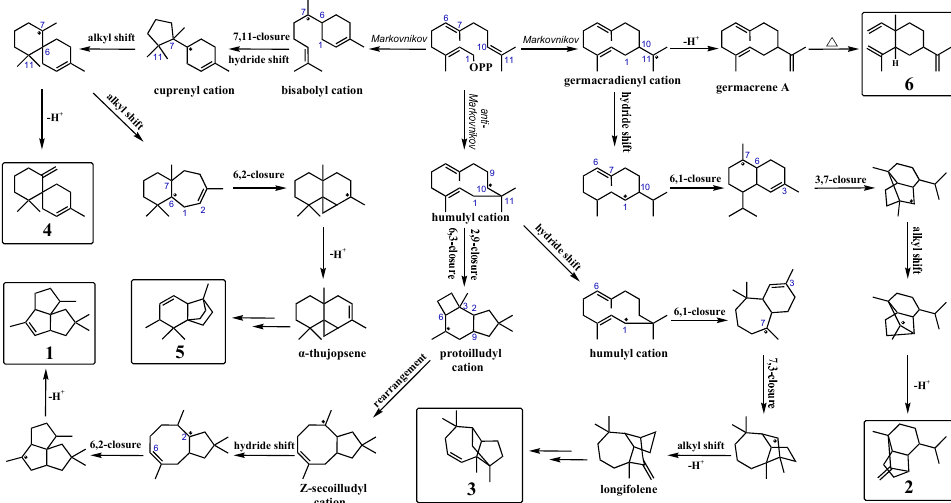
Figure 3. Predicted sesquiterpenes biosynthetic pathways of wild-type PentS and its variants. The products 1 and 3 were pentalenene and longifolene-V4, respectively, which were synthesized through anti-Markovnikov route initialed by 10, 11 double-bond attacked C1 and formed humulyl cation with positive charge on the less-substituted carbon (C10). The products 2 (sativene) and 6 ( β -elemene) were generated obeying Markovnikov’s rule initialed by 10, 11 double-bond attacked C1 and formed germacradienyl cation with positive charge on the more highly substituted carbon (C11). The products 4 ( β -chamigrene) and 5 (thujopsene-I3) were also generated following Markovnikov’s rule initialed by 6, 7 double-bond attacking of C1 and formed bisabolyl cation with positive charge on the more highly substituted carbon